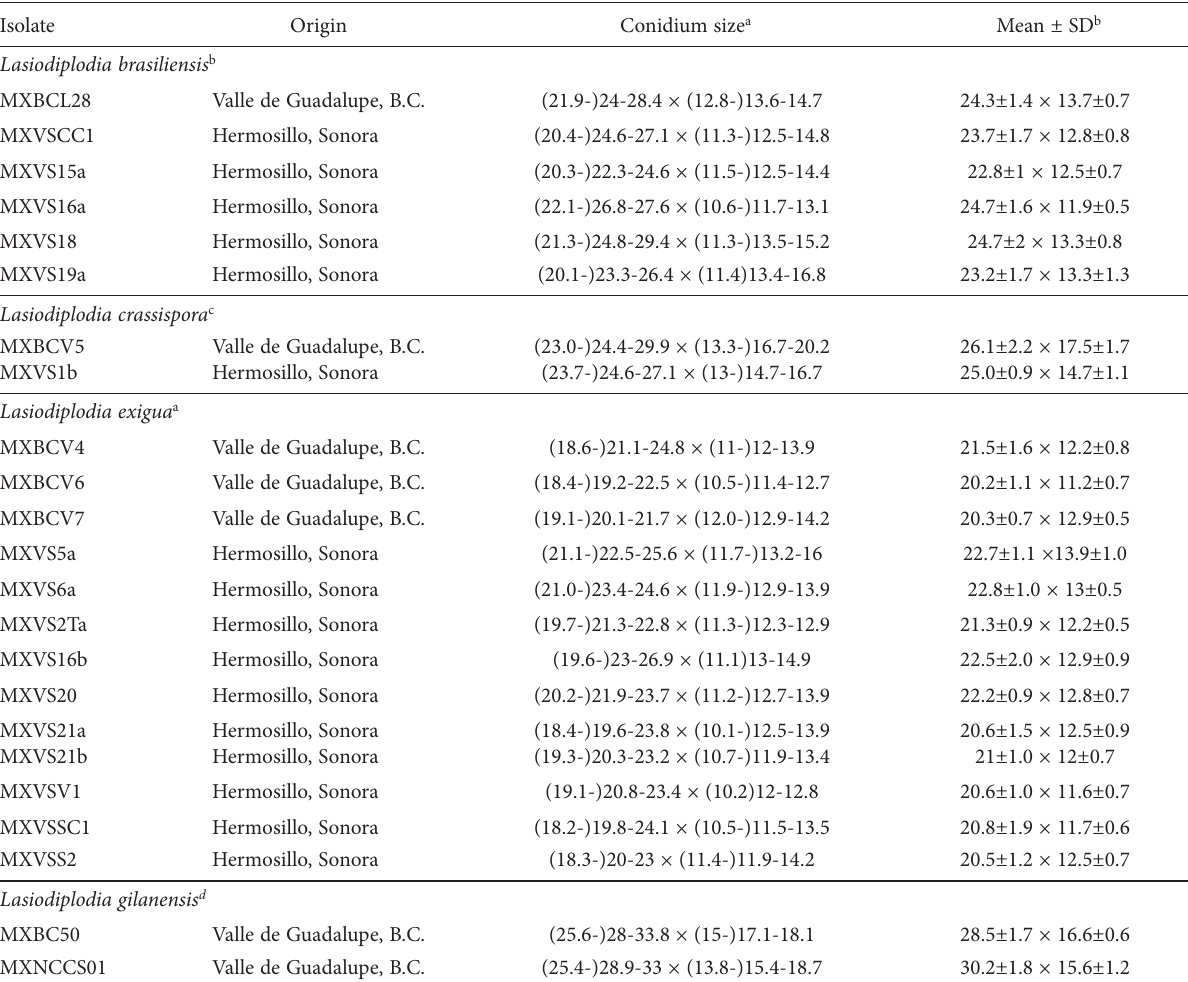
Table 2. Conidium dimensions of the Lasiodiplodia spp. isolates from this study.